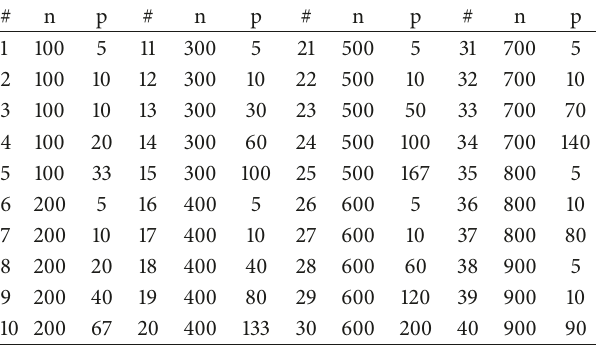
We compute the 𝛼 threshold in such a way that 15% of the distances between nodes are lower than 𝛼